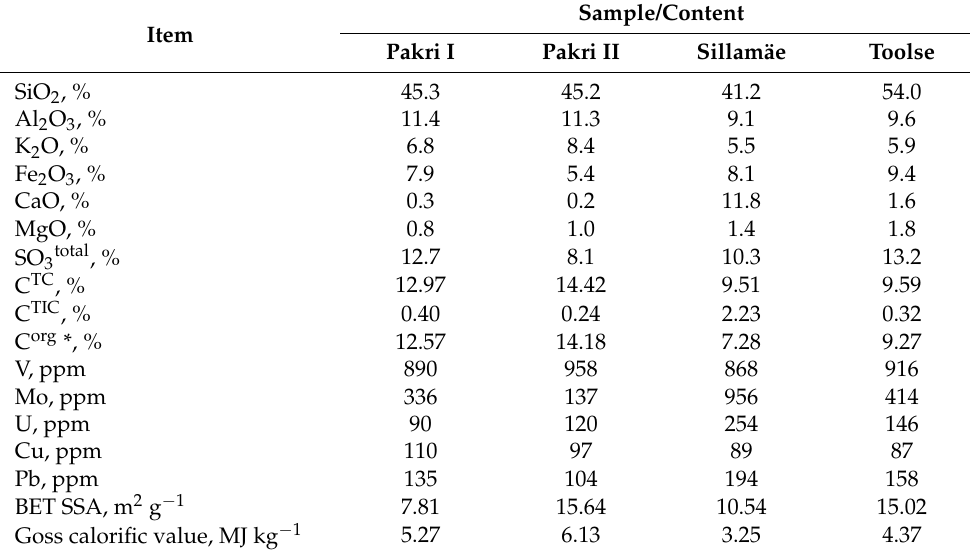
Table 2. Chemical composition (wt% or ppm), SSA, and calorific value of GA samples.